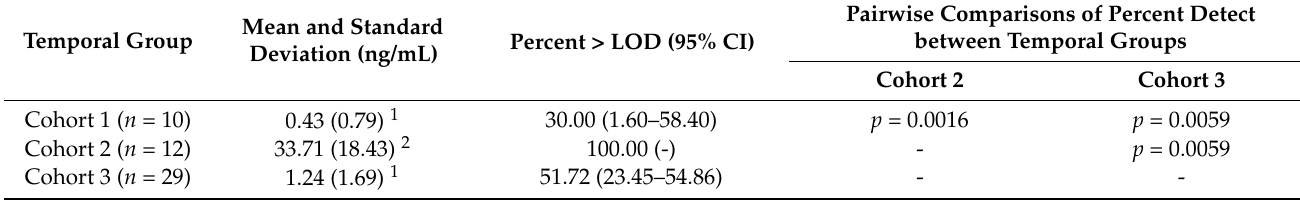
Table 2. Mono(2-ethylhexyl) phthalate (MEHP) mean and standard deviation values for temporal groups: (1) Cohort 1 (i.e., samples collected 2010–2013); (2) Cohort 2 (i.e., samples collected 2014–2015); (3) Cohort 3 (i.e., samples collected 2016–2019). Since the Peto–Peto p < 0.05, pairwise multiple comparison tests were conducted between groups with Benjamini–Hochberg (BH)